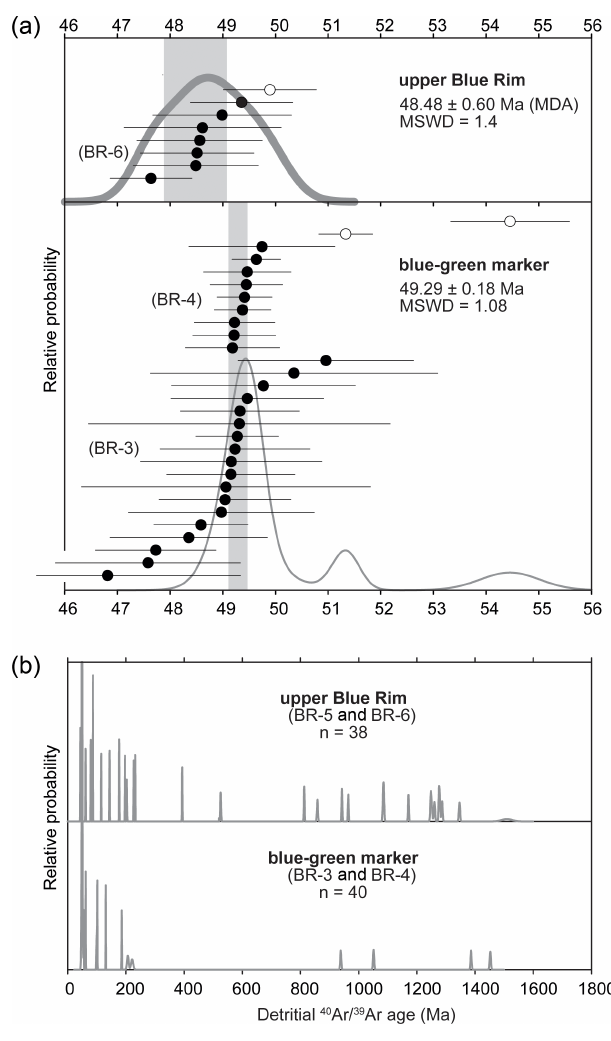
Figure 8. 40 Ar / 39 Ar geochronology: (a) relative probability plots of Eocene-aged sanidine from the volcaniclastic–lacustrine blue– green marker and an overlying pumice-bearing volcaniclastic sand- stone (sample BR-6); (b) relative probability plot of 40 Ar / 39 Ar ages for detrital feldspar grains from the middle and upper Blue Rim, showing Phanerozoic and late Paleozoic ages characteristic of the Idaho paleoriver (see Chetel et al.,